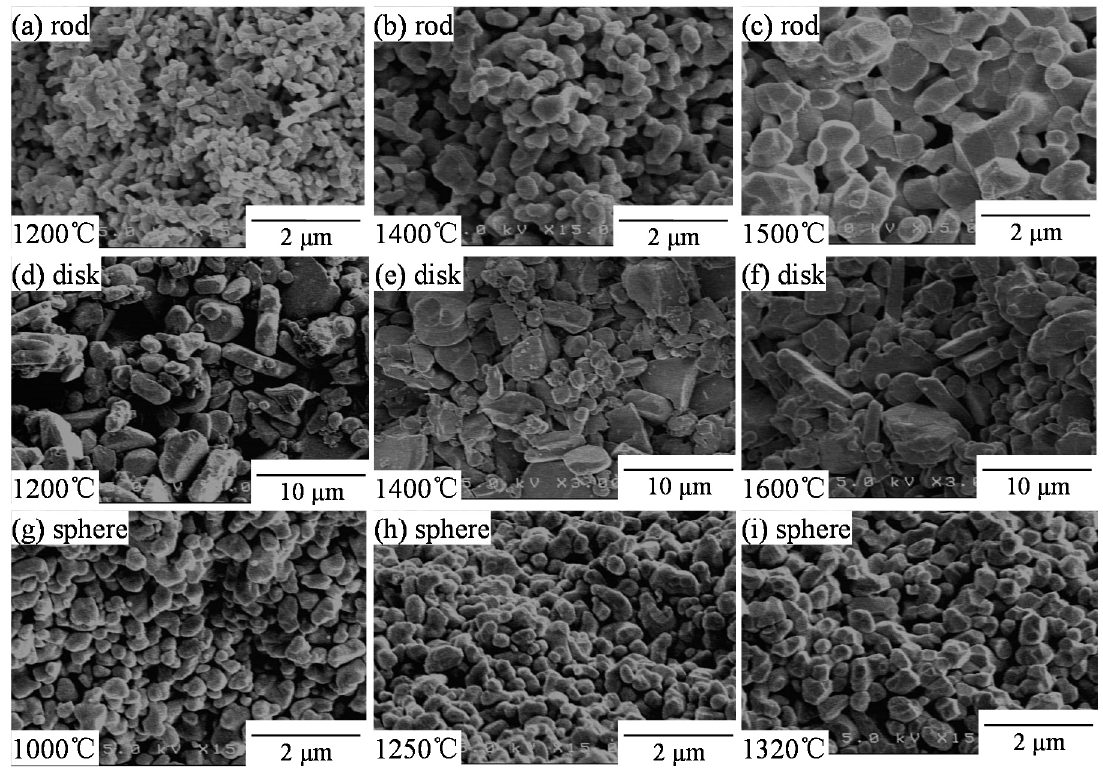
Figure 7. Fractured surfaces of alumina compacts sintered from ( a – c ) rod-like particles, ( d – f ) disk-like particles, and ( g – i ) spherical particle at 1000–1600 °C.